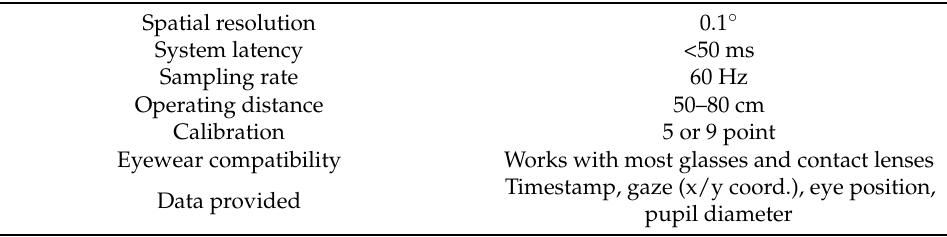
Table 1. Specifications of GP3 Eye Tracker from Gazepoint , the eye-tracking software used in the experiment.